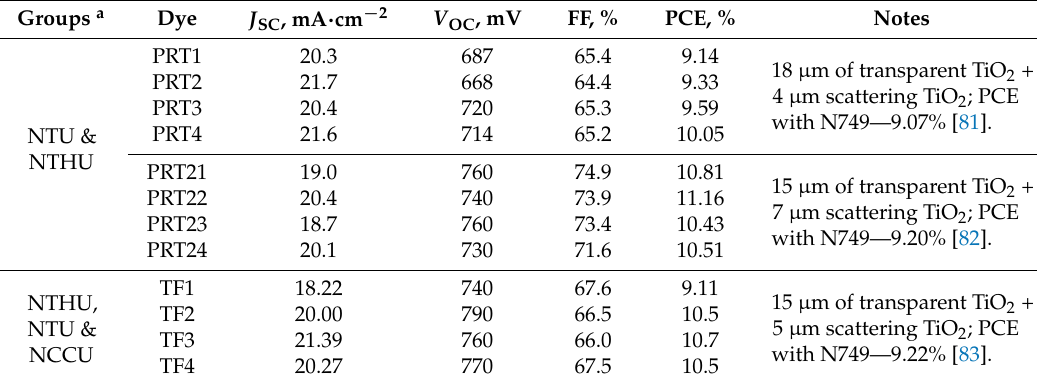
Table 4. Photovoltaic performance of selected PRT and TF series sensitizers with bidentate and tridentate